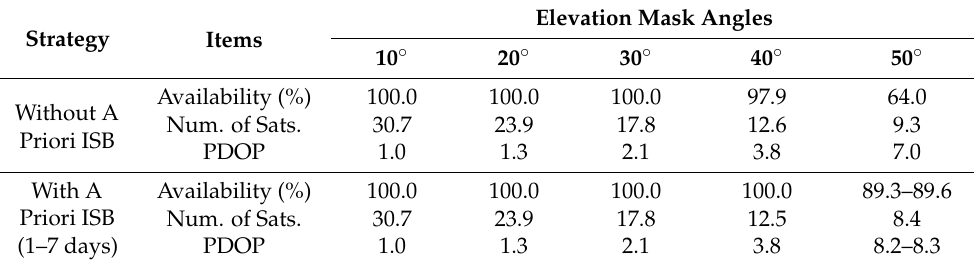
Table 6. Availability, satellite number, and PDOP value of four-system integrated SPP with and without a priori ISB constraints under different elevation masks.